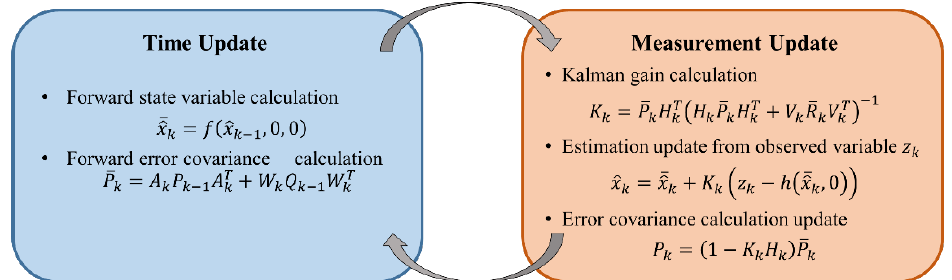
Figure 1. Extended Kalman filter (EKF) algorithm flow is divided into two parts: time update and measurement update. Among them, k − 1 and k represent the previous state and current state respectively, ˆ x k is the priori estimate of current state, ˆ x k is the posteriori estimate of the current state, z k is the measurement vector, f ( · ) is the nonlinear mapping equation from the previous state to the current state, h ( · ) is the nonlinear mapping equation between state and measurement, Q is the covariance matrix, A is the Jacobian matrix of the partial derivative of f ( · ) with respect to x , W is the Jacobian matrix of the partial derivative of f ( · ) with respect to noise, H is the Jacobian matrix of the partial derivative of h ( · ) with respect to x , and V is the Jacobian matrix of the partial derivative of h ( · ) with respect to noise.